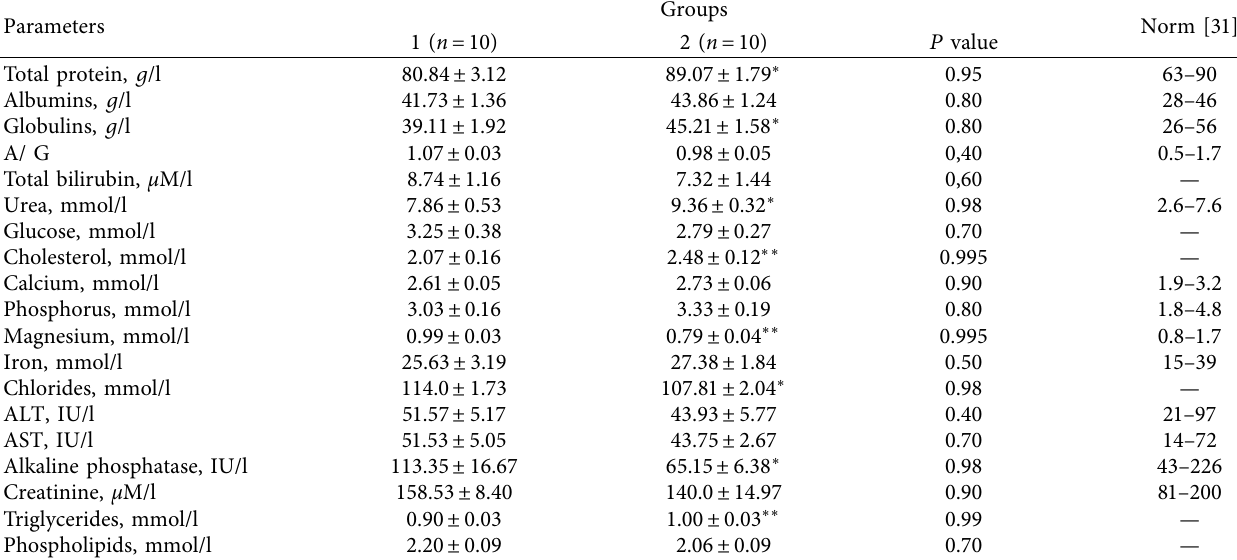
Table 1: Indicators of metabolic processes in the body of sows after weaning.